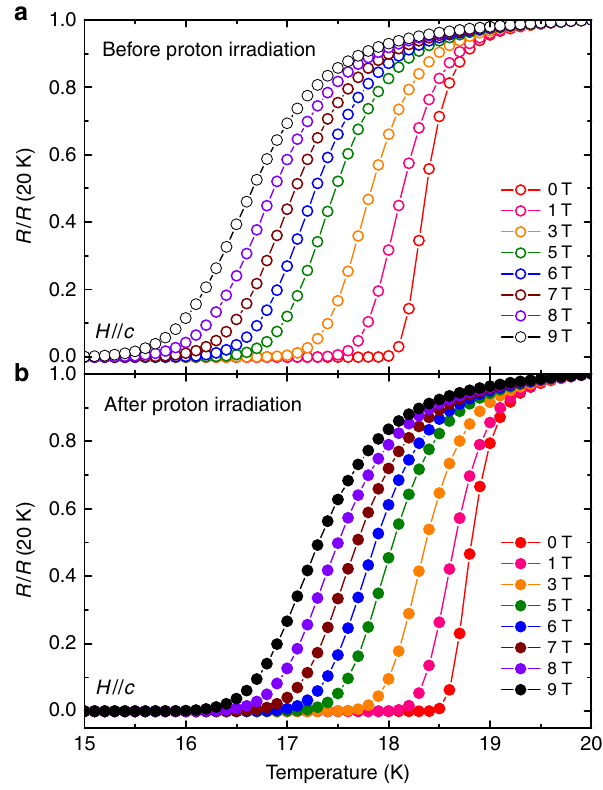
Figure 1 | Temperature dependence of normalized resistivity. r ( T )/ r (20K) at 0–9T// c for the FST film before ( a ) and after ( b ) 190keV